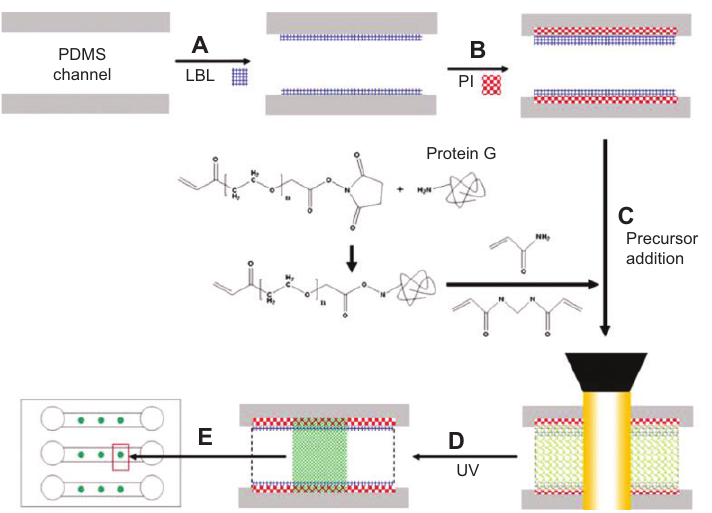
Figure 5 Fabrication of protein G-immobilized hydrogel chip. (A) PDMS surface modification with PEMs [poly(ethyleneimine)/PAAc] in the microchannel via LBL. (B) Absorption of the photoinitiator (PI) into the PEMs-modified PDMS microchannel. (C) Protein G is covalently bonded to NHSPEG-acrylate molecules for copolymerization with acrylamide/bisacrylamide. (D) Certain regions in the PEM-modified PDMS microchannel are exposed to UV light through a microscope objective for in situ synthesis of hydrogel plugs in the PEM-modified PDMS microchannel. (E) Patterned hydrogel plugs are formed within PDMS microchannels (Sung et al. 2009